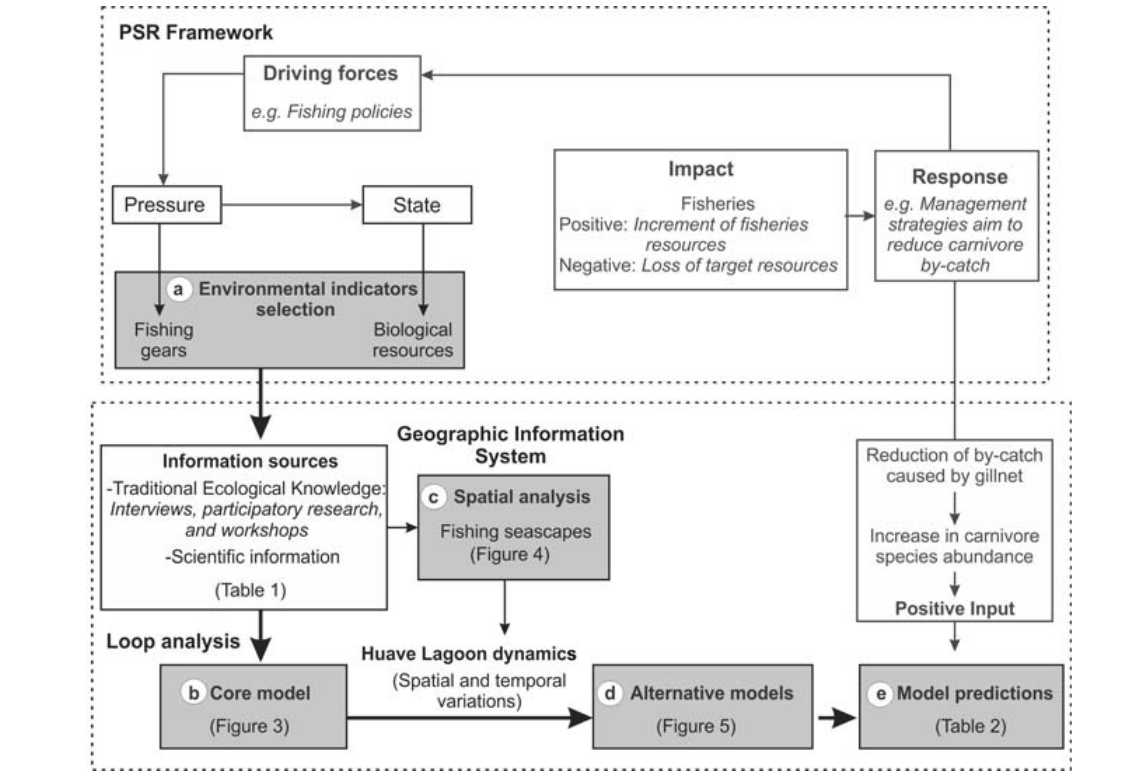
Fig. 2 . Flow diagram showing the assembly of the analysis tools that were utilized: (1) pressure-state-response, (2) loop analysis, and (3) Geographic Information System. The assemblage is subdivided into five steps (gray boxes): (a) indicator selection, (b) core model, (c) spatial analysis, (d) alternative models, and (e) model predictions (modified from Espinoza- Tenorio et al. 2010 b